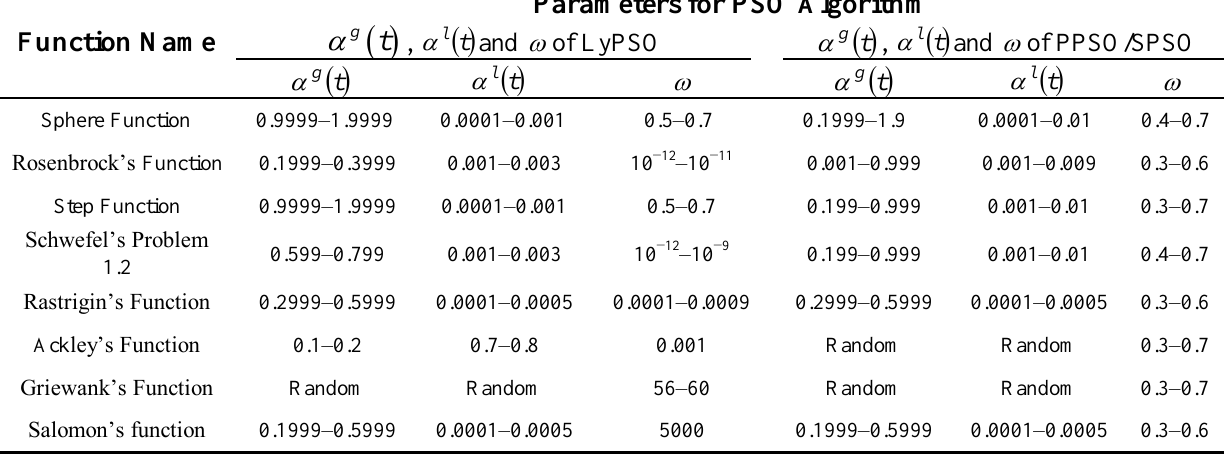
Table 5. Range of optimal values